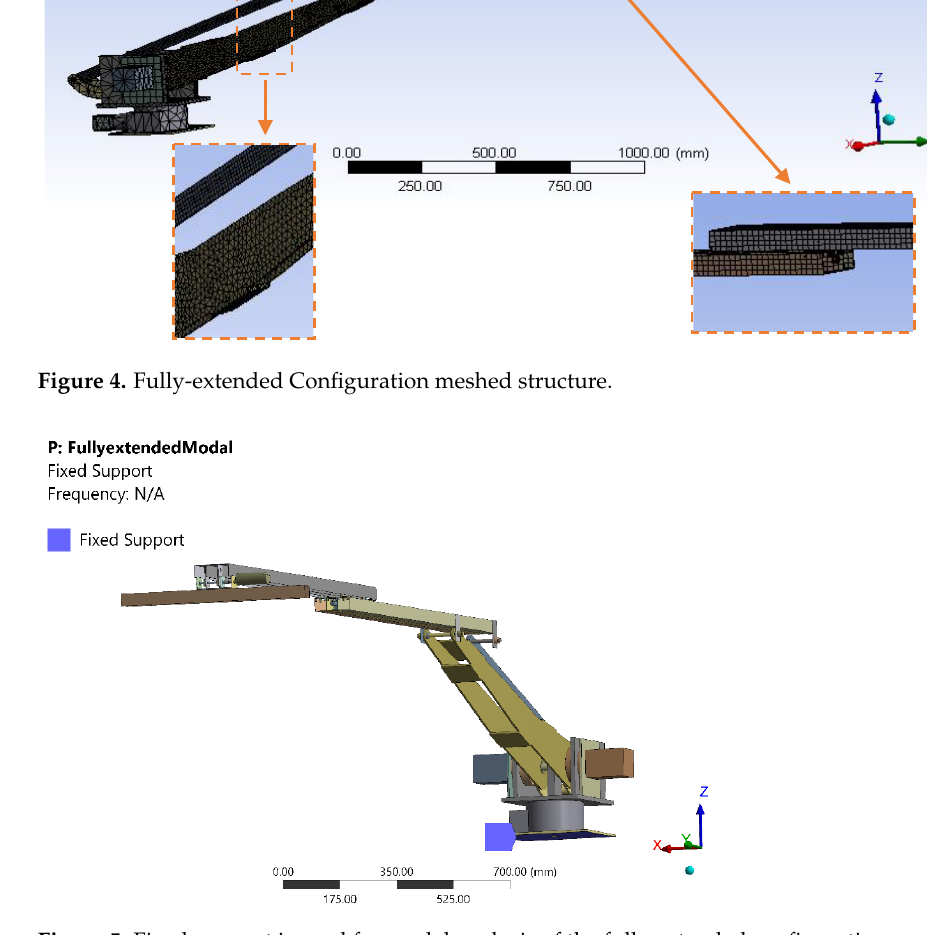
Figure 5. Fixed support is used for modal analysis of the fully extended configuration.